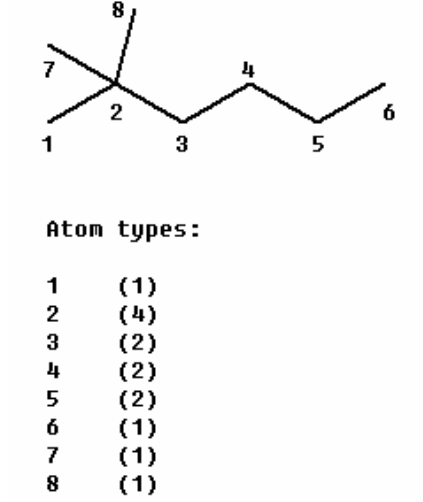
index of 2, 2-dimethylhexane into atom contributions. 1